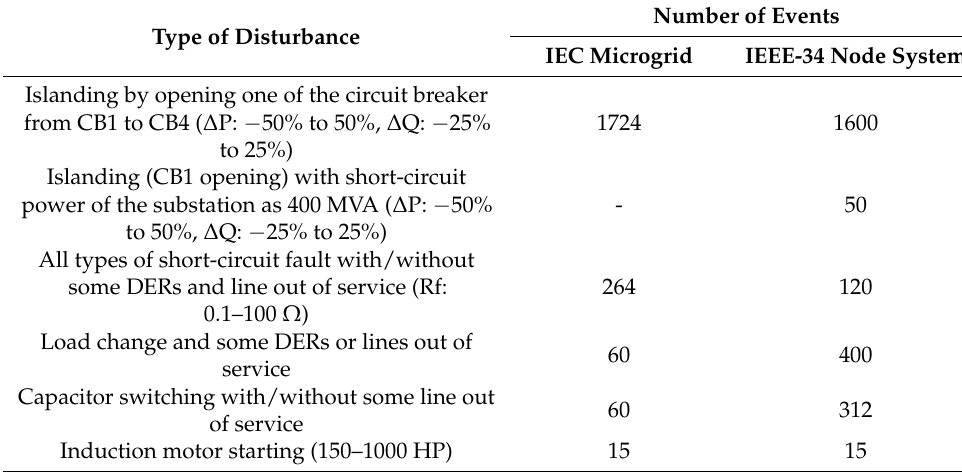
Table 1. Simulation scenarios of the test